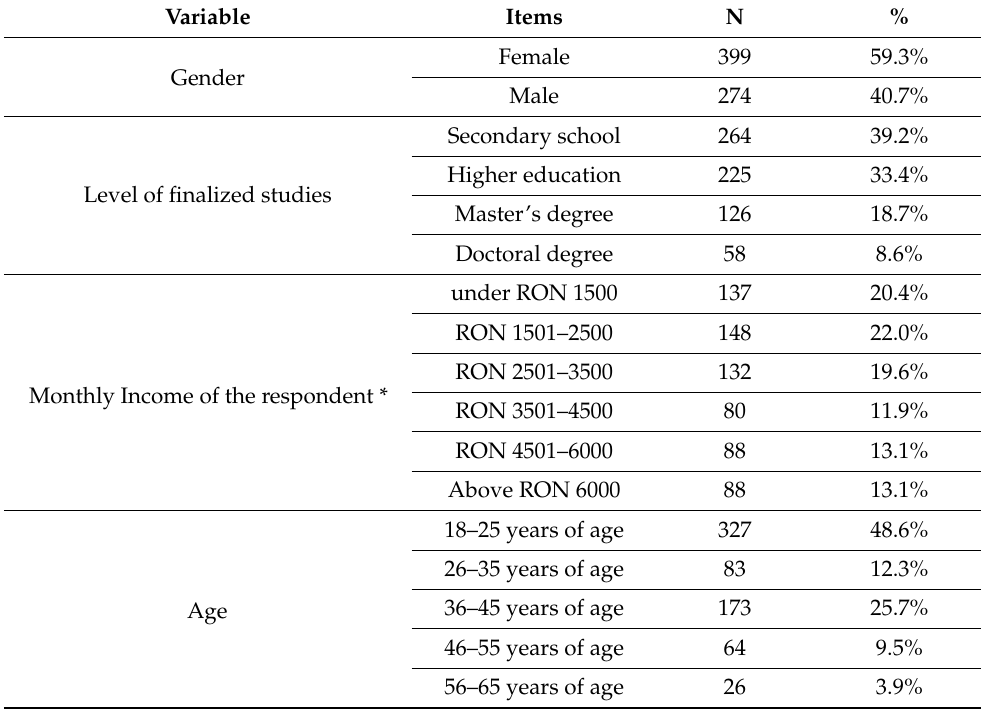
Table 1. Sample profile ( n =